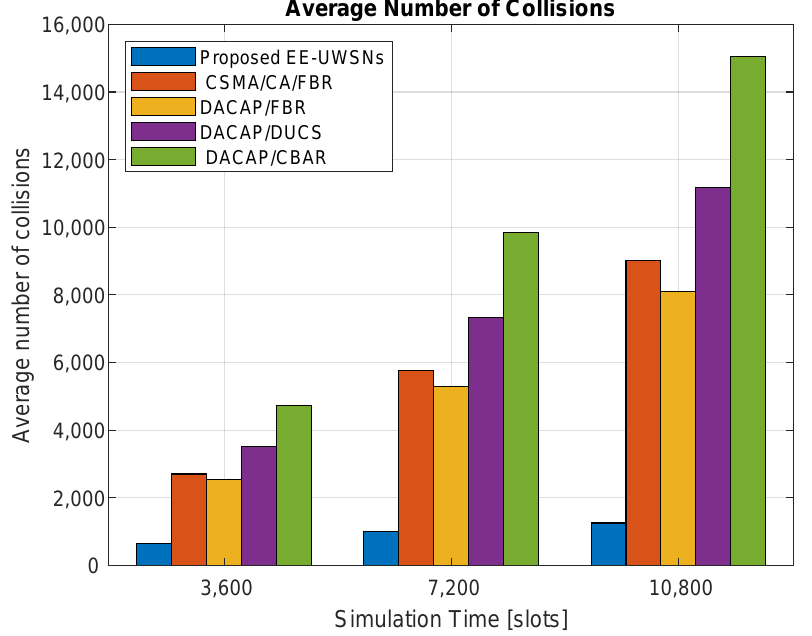
Figure 10. Average number of collisions.